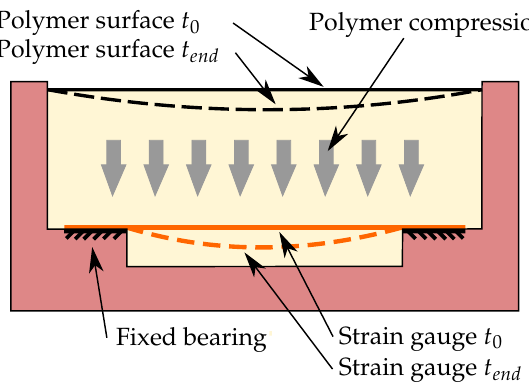
Figure 4. Polymer and strain gauge movement during the experiment. The thickness of the polymer layer is exaggerated to illustrate the